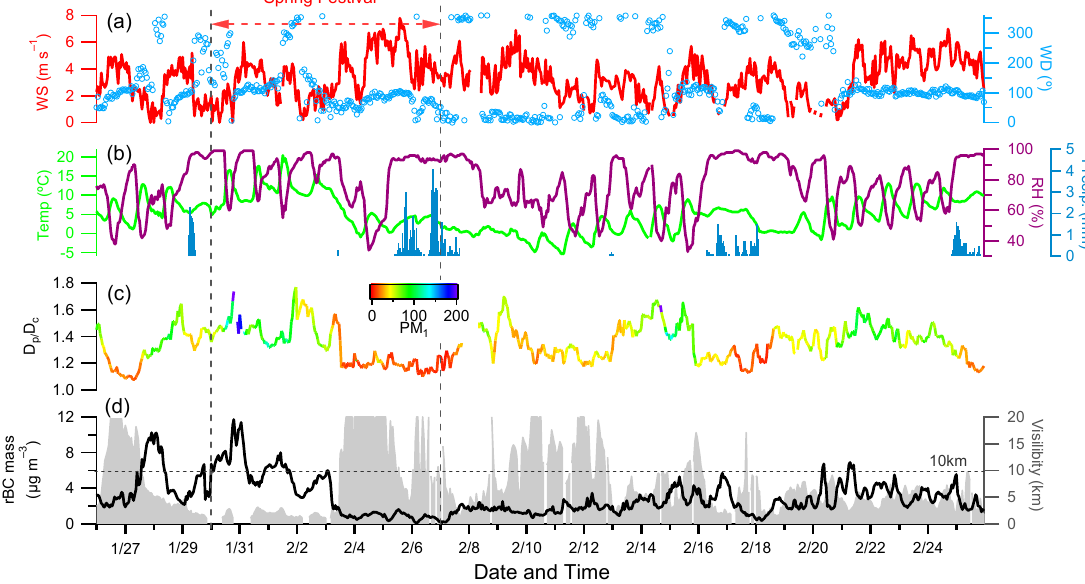
Figure 2. Time series of hourly-average ( a ) wind speed, wind direction, ( b ) temperature, relative humidity, precipitation, ( c ) relative coating thickness coated/uncoated diameter ( D p / D c ), and PM 1 , ( d ) visibility and mass concentrations of refractory BC (rBC).